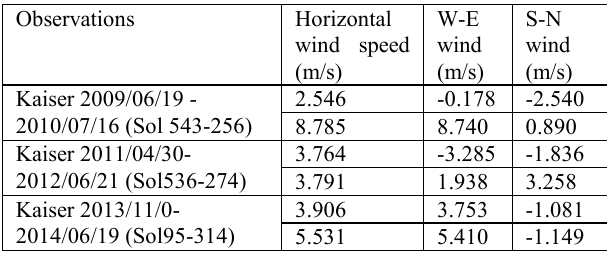
Figure 9. Examples of artifacts by radiometric changes over surfaces ESP 027667 (2012/06/21) - ESP037372 (2014/07/17) a. Osculation by Co2 frost, b. artefacts by shadow and active seasonal CO2 gully networks which rejected by blunder detection component